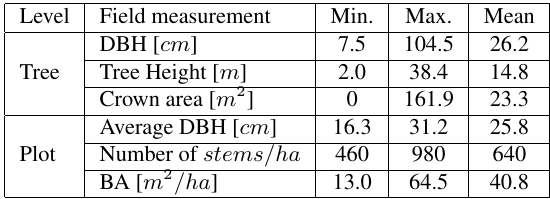
Table 1: Summary of the field measurements at tree- and plot- level. Minimum (Min), Maximum (Max) and Mean are dis- played. BA refers to basal area.